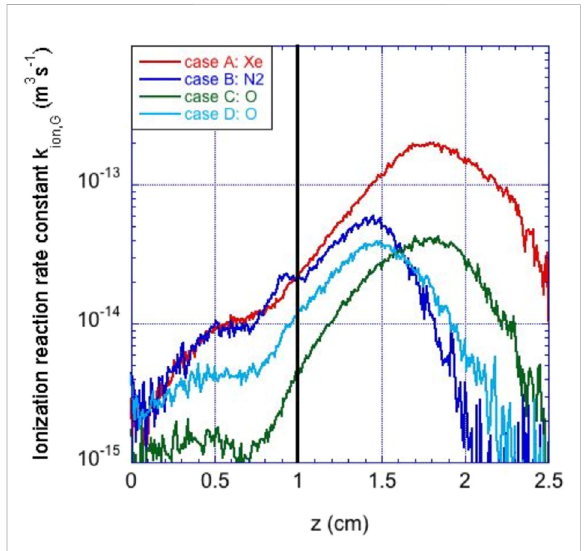
FIGURE 11 Axial pro fi les along the channel thruster centerline of the ionization reaction rate coef fi cient k ion , G (m 3 s − 1 ) (Eq. 18) for the dominant gas species for the different cases (molecular nitrogen N 2 for case B and atomic oxygen O for cases C and D). The black vertical line corresponds to the exit plane location.